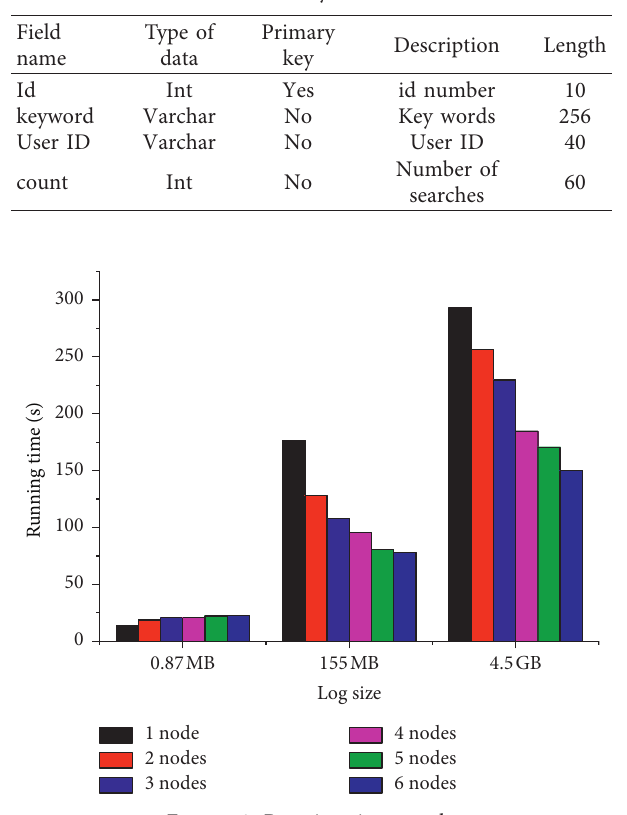
Figure 2: Data storage procedure diagram. Table 1: Keyword list.